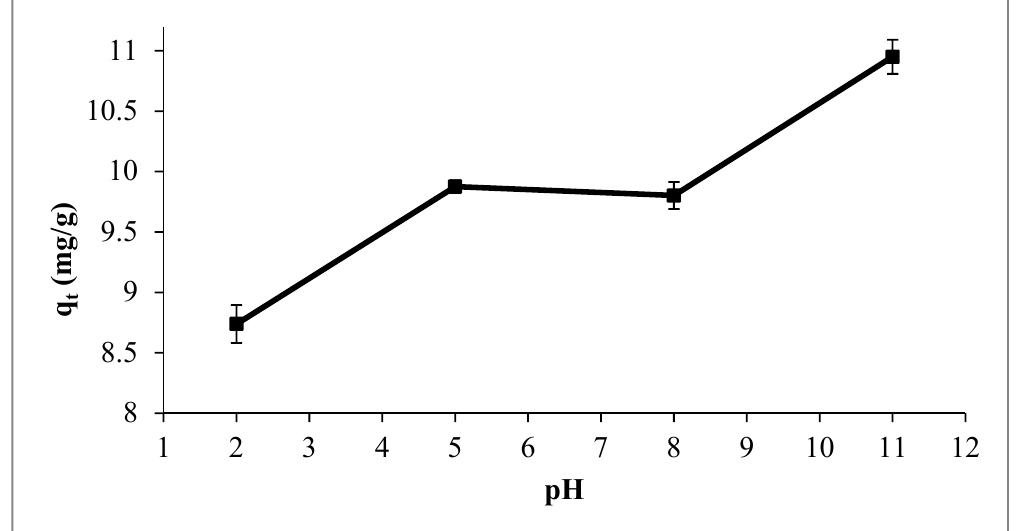
Figure 10. The influence of OMW pH on the TPC uptake using 1% by wt. adsorbent dose, 124 mg/L initial TPC concentration, at temperature of 295 K, and contact time of 24 h.